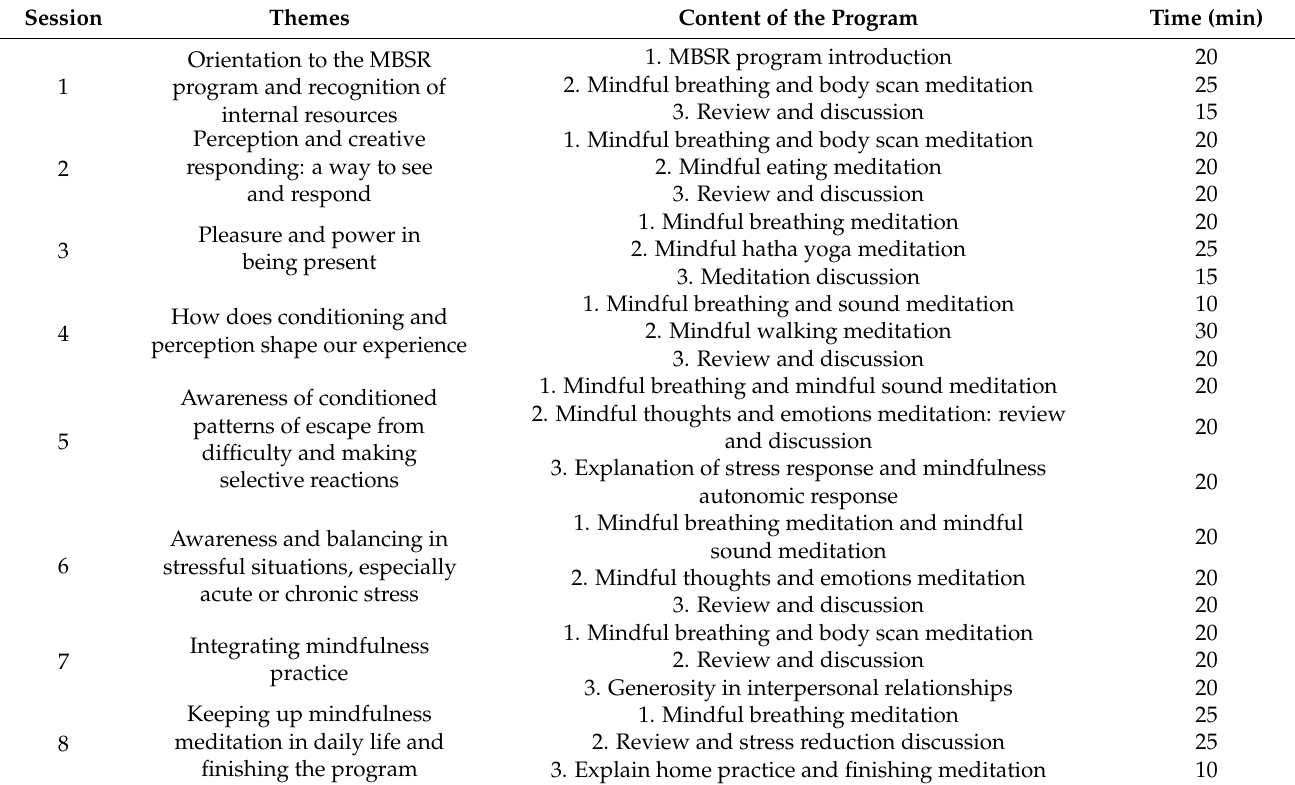
Table 1. Mindfulness-based stress reduction program of the